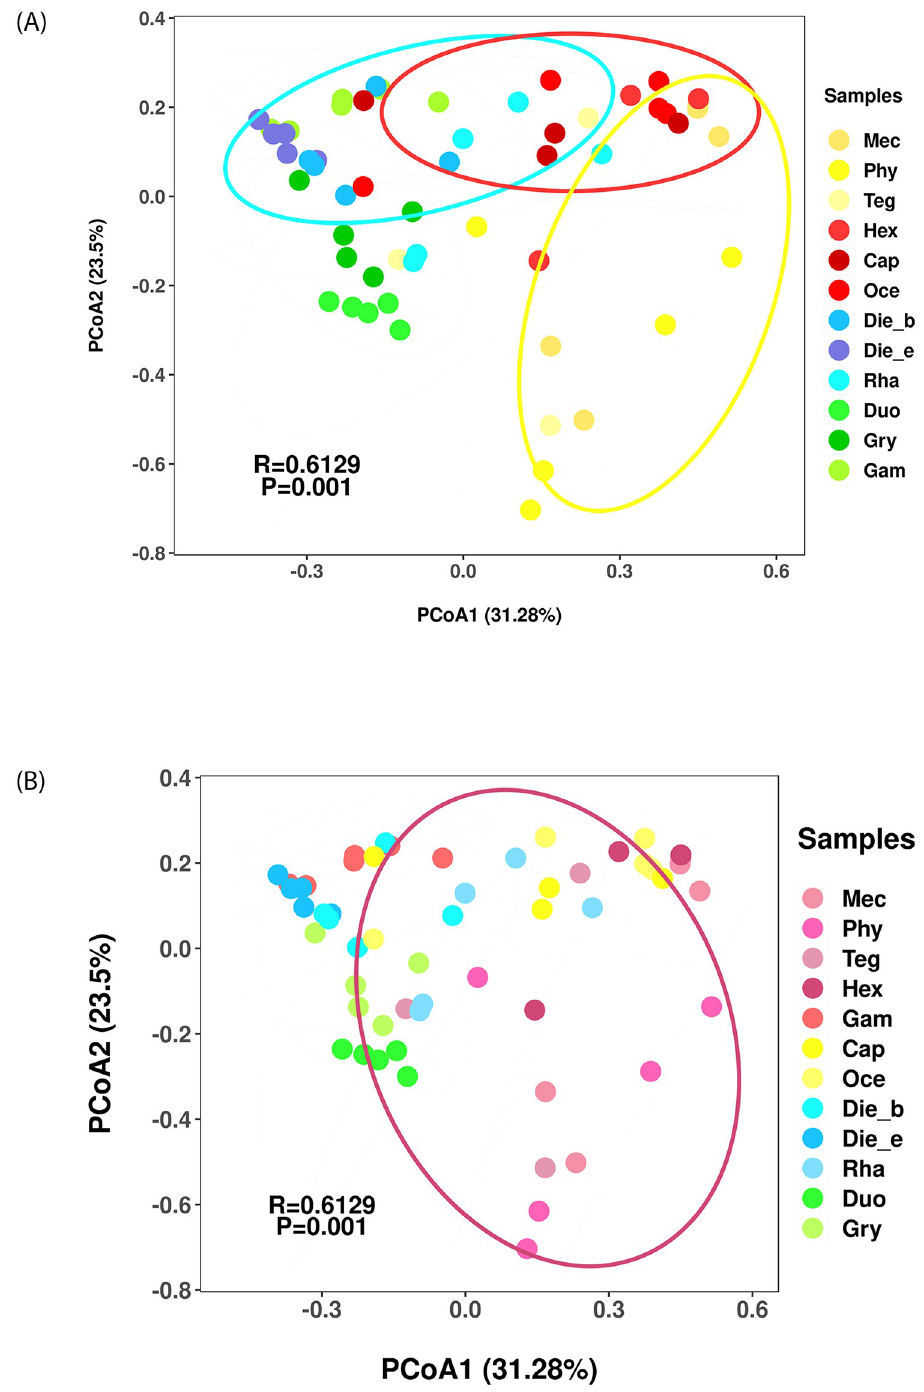
Fig 3. Bacterial communities clustered by using principal coordinates analysis (PCoA) based on the weighted unifrac distance. Eigenvalues of PCoA1 and PCoA2 are shown in parentheses. Samples were colored according to insects feeding habits (A) and insects taxonomy on family level